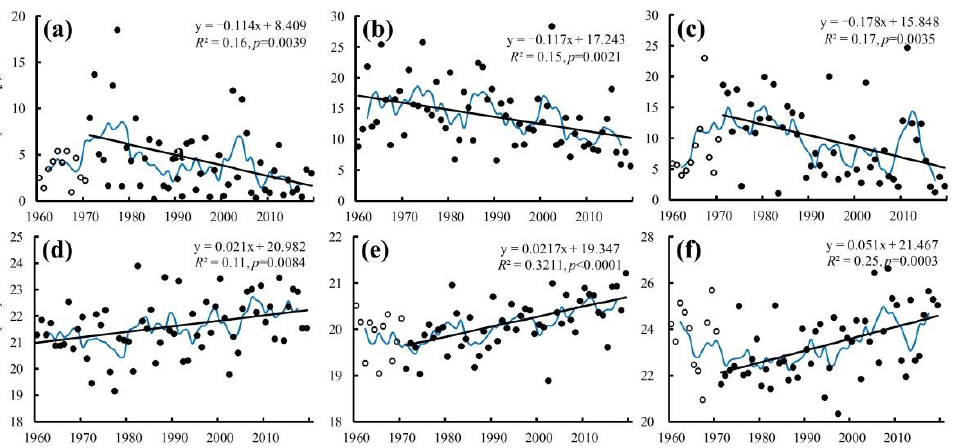
Figure 4. Changes in temperature indices during heading and flowering from 1960 to 2019 (blue curves denote the 5-year moving average of the temperature indices; black lines are the regression trend lines using the black solid dots): ( a , d ) single rice in NEP; ( b , e ) single rice in YNP; ( c , f ) late rice in SMLYR.